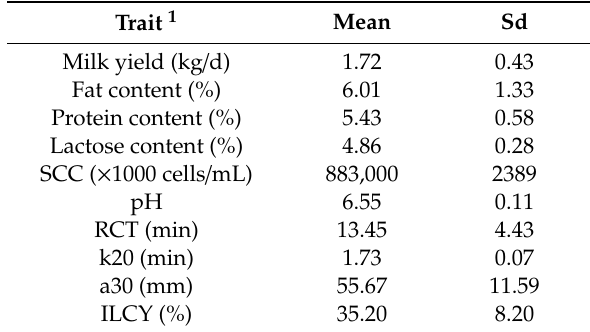
Table 1. Average values for milk composition traits, milk coagulation properties, and individual cheese yield of the considered sample of ewes.